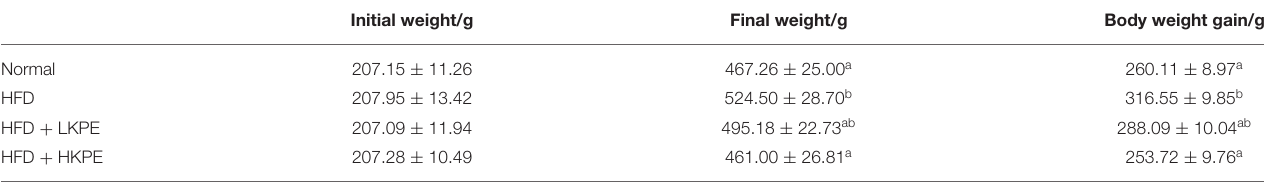
TABLE 3 | Effects of KPE on the body weight of rats with high fat